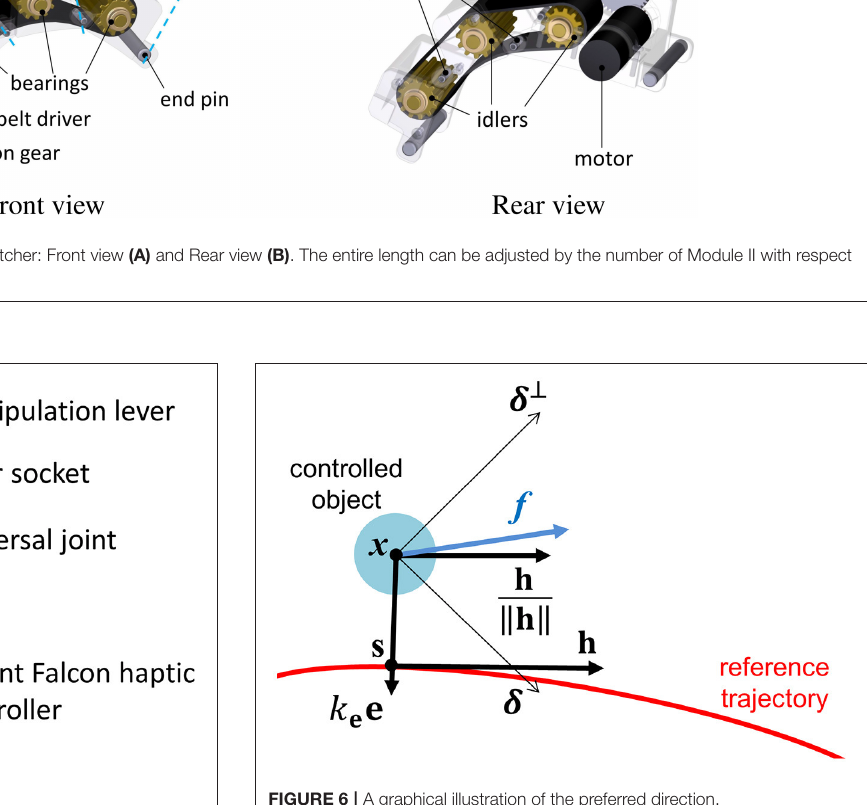
FIGURE 5 | The modified 2D haptic joystick: 3D movement maps into 2D plane by adopting the universal joint and the lever socket.